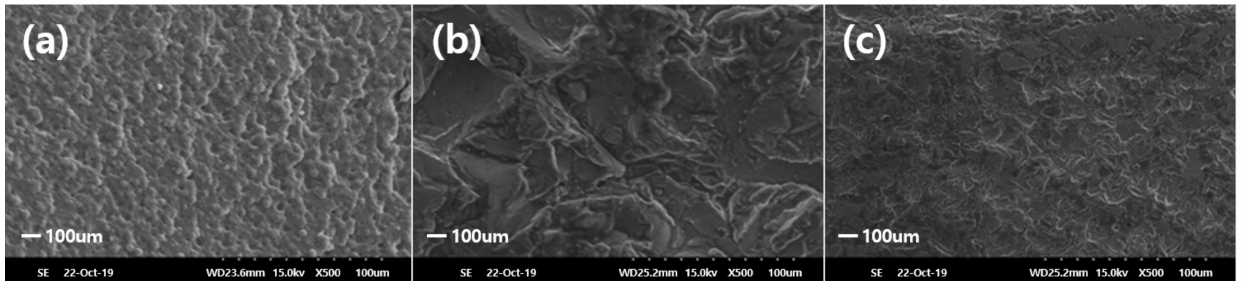
Figure 3. Cross-sectional morphology images of binder with improved shear strength: ( a ) 5 wt% TMSPMA, ( b ) 15 wt% TMSPMA, ( c ) 25 wt%